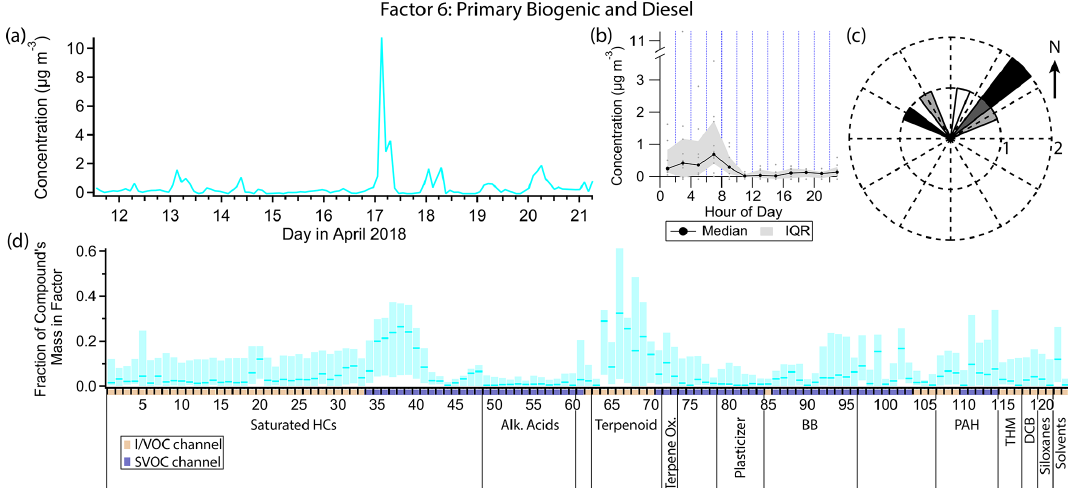
Figure 11. (a) Factor 6 timeline. (b) Diurnal profile for Factor 6. (c) Rose plot showing correlation of elevated emissions and wind direction. (d) Factor 6 composition profile. See Fig. 4 description for further information on how to read this